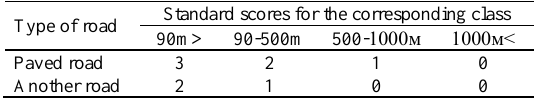
Table 2. Distance from the road.